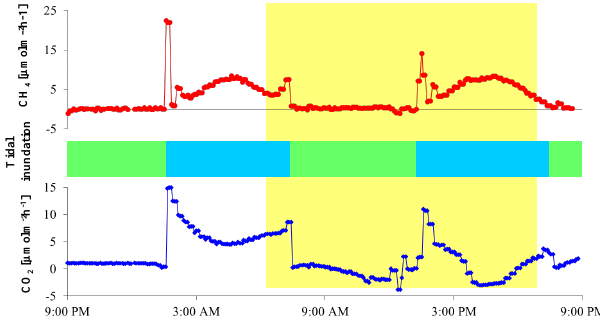
Figure 3. CH 4 and CO 2 fluxes above a bare sediment patch recorded on 23 April 2012. The upper graph in red shows the CH 4 fluxes in µmolm − 2 h − 1 and the lower graph show the CO 2 fluxes in mmolm − 2 h − 1 . The yellow bar indicates daylight periods, green bars indicate periods of air exposure, and blue bars indicate periods of tidal immersion. Table 1. Averaged CO 2 and CH 4 fluxes above seagrass for different periods of the tidal cycle. The fluxes were calculated from the mea- surements of day 2 and 3. By definition, emission fluxes are positive and deposition fluxes are